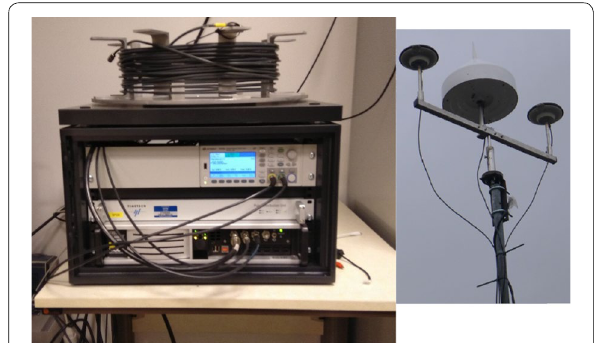
Fig. 6 BIPM new travelling GNSS station for